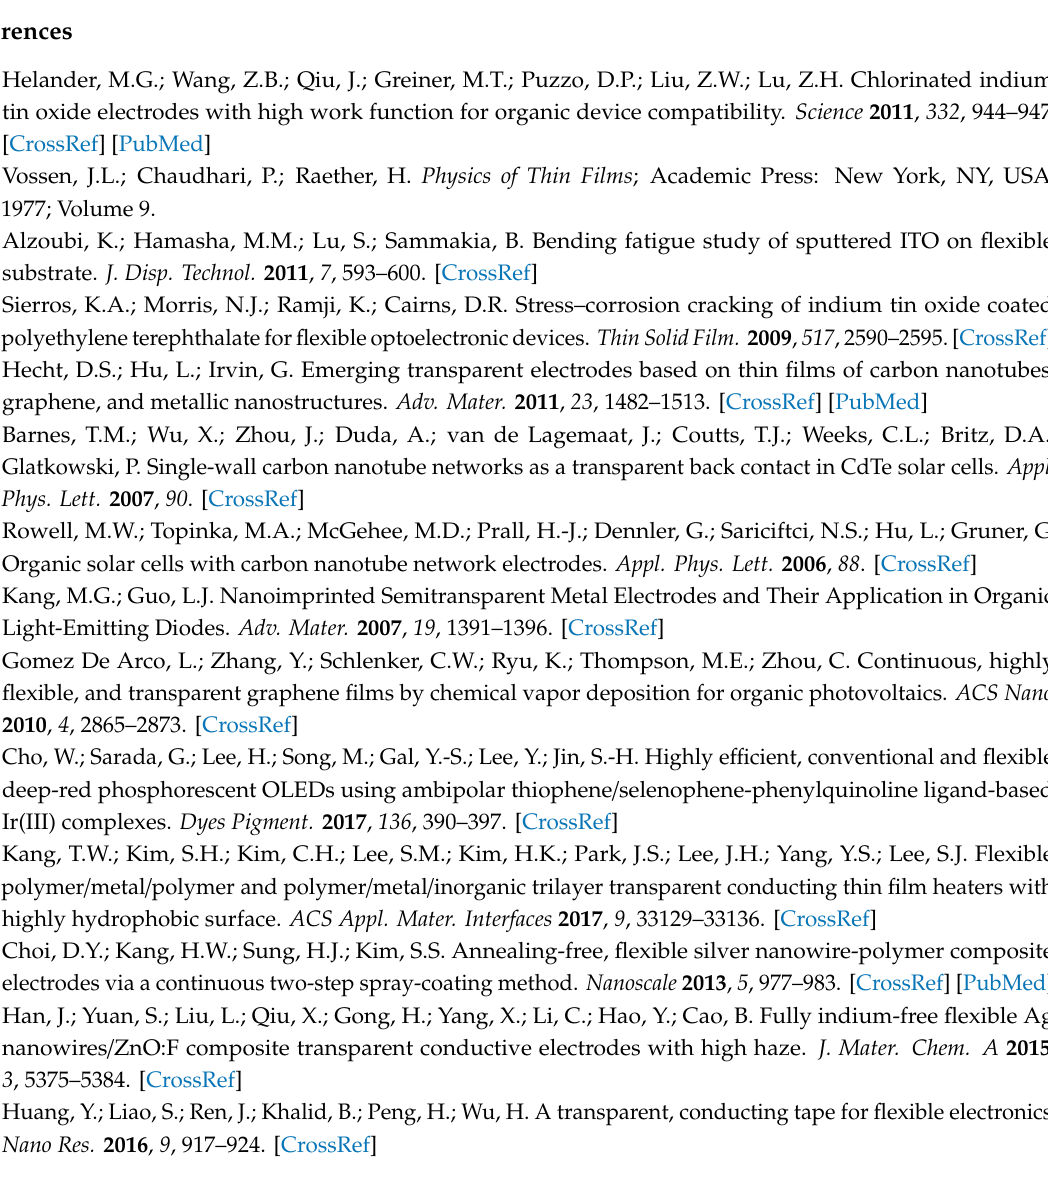
Figure S1: Raman spectra of GO and GCA. Figure S2: FT-IR data of GO and